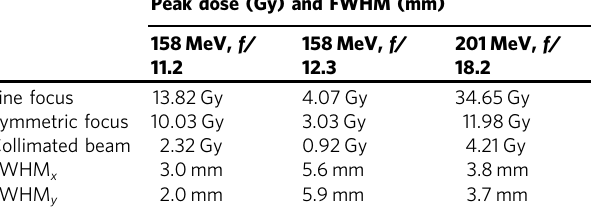
Table 1 Peak dose and full-width at half-maximum (FWHM) obtained from x and y projections of the transverse beam pro fi le at the focus depth, for different beam geometries obtained with the FLUKA MC code.